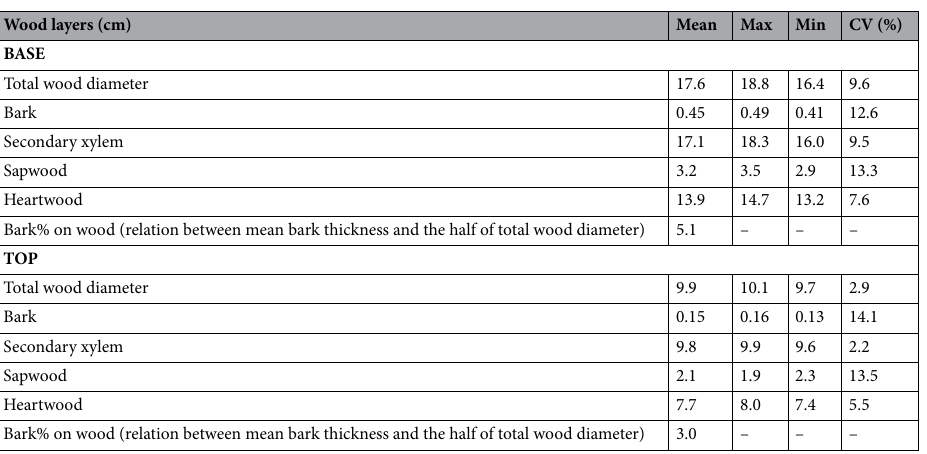
Table 1. Macroscopic characterization of Pterogyne nitens wood. Max maximum value, Min minimum value, CV coefficient of